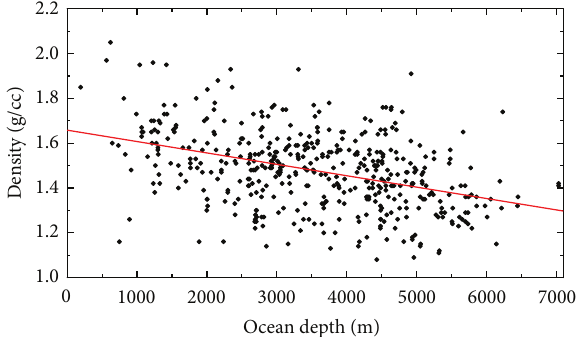
Figure 4: Relation between the marine sediment density and the ocean depth. The density samples were taken within the upper sediment layer (the sediment depth is < 50m). Theoretical density values (red line) were calculated using the upper sediment density equation in (1).